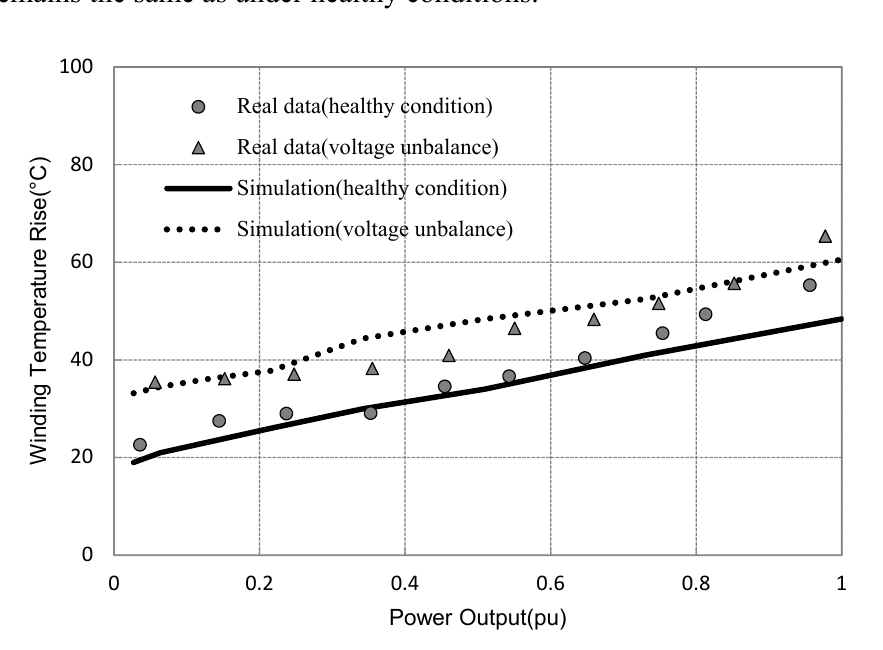
Figure 14. Winding temperature rise against normalized power output when the DFIG is under healthy conditions and with voltage